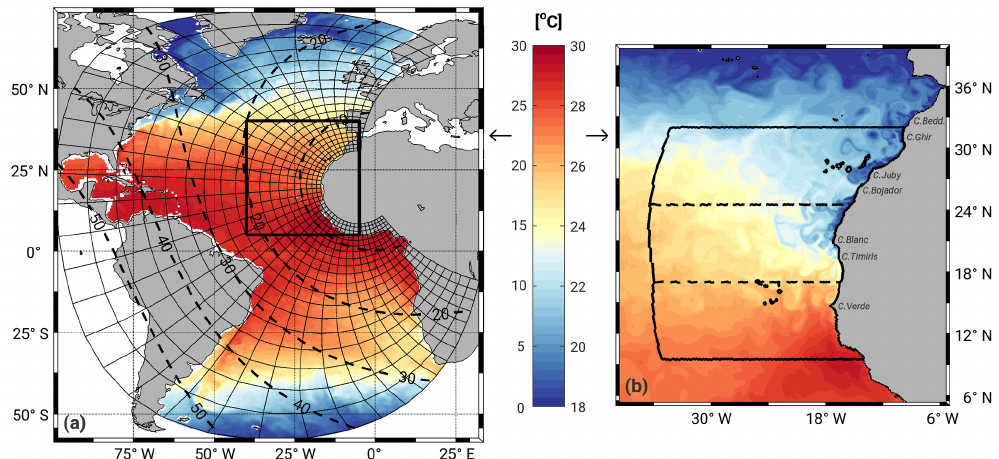
Figure 1. Model grid and CanUS domain superimposed on an instantaneous snapshot of sea surface temperature [ ◦ C] from 1 December of year 30 of the run. (a) Atlantic telescopic grid showing every 20th grid line (solid lines) with isolines of grid resolution in km (dashed lines); the black square highlights the CanUS region used for the zoomed-in plot. (b) Zoom on the CanUS region including the names of the major capes and the boundaries of the regional and subregional domains used for the analyses. The western boundary (solid line) is located at 2000km offshore distance, the northernmost and southernmost regional boundaries (solid lines) are set at 9.5 and 32 ◦ N, respectively. The subregional boundaries (dashed lines) are located at 17 and 24.5 ◦ N and divide the CanUS region into three subregions: southern, central and northern